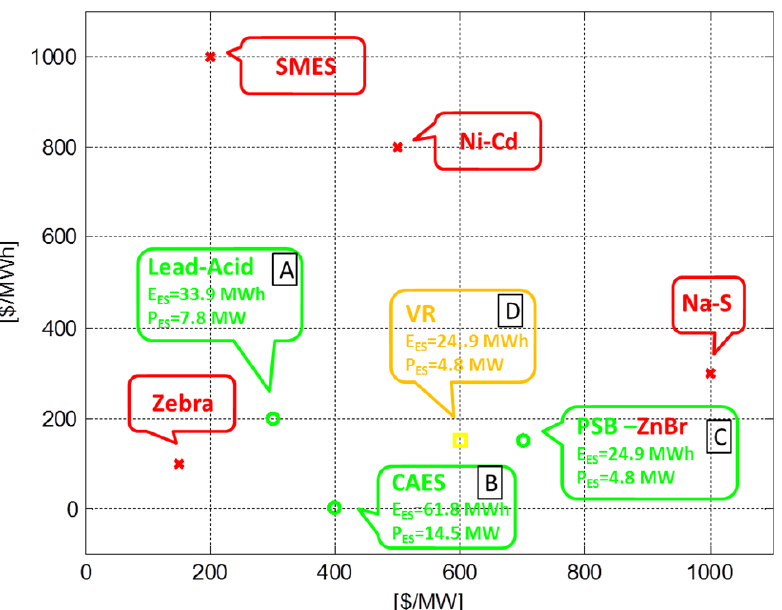
Figure 10. ESS technology applicability and optimal sizing based on economic parameters from